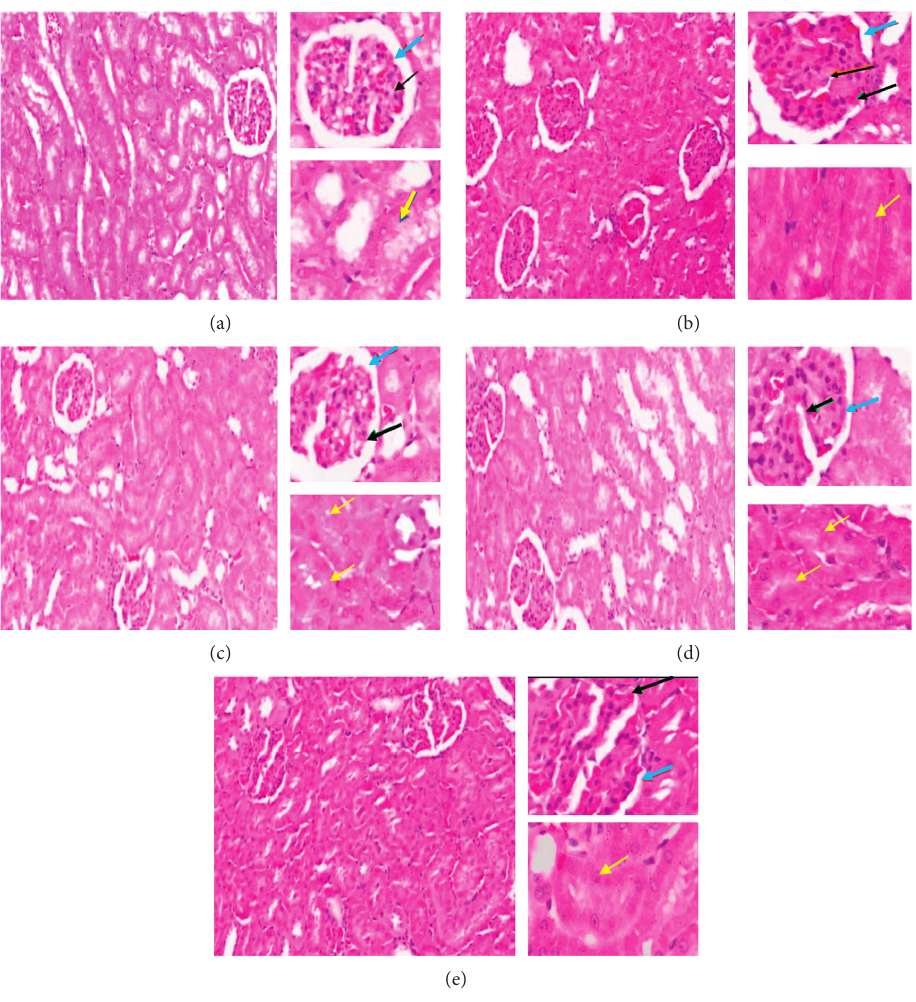
Figure 2: Histopathological profiles of the kidney of (a) healthy rats (group 1), (b) diabetic rats (group 2), (c) diabetic rats that treated with 250mg/kg body weight extracts per day (group 3), (d) diabetic rats that treated with 375mg/kg body weight extracts per day (group 4), and (e) diabetic rats that treated with 500mg/kg body weight extracts per day (group 5). Number 1 shows overview of the kidney with 10 × magnification, number 2 shows glomerulus area with 40 × magnification, and number 3 shows tubules with 40 × magnification. Black arrows show glomerulus, yellow arrows show proximal tubules, and blue arrows show Bowman’s